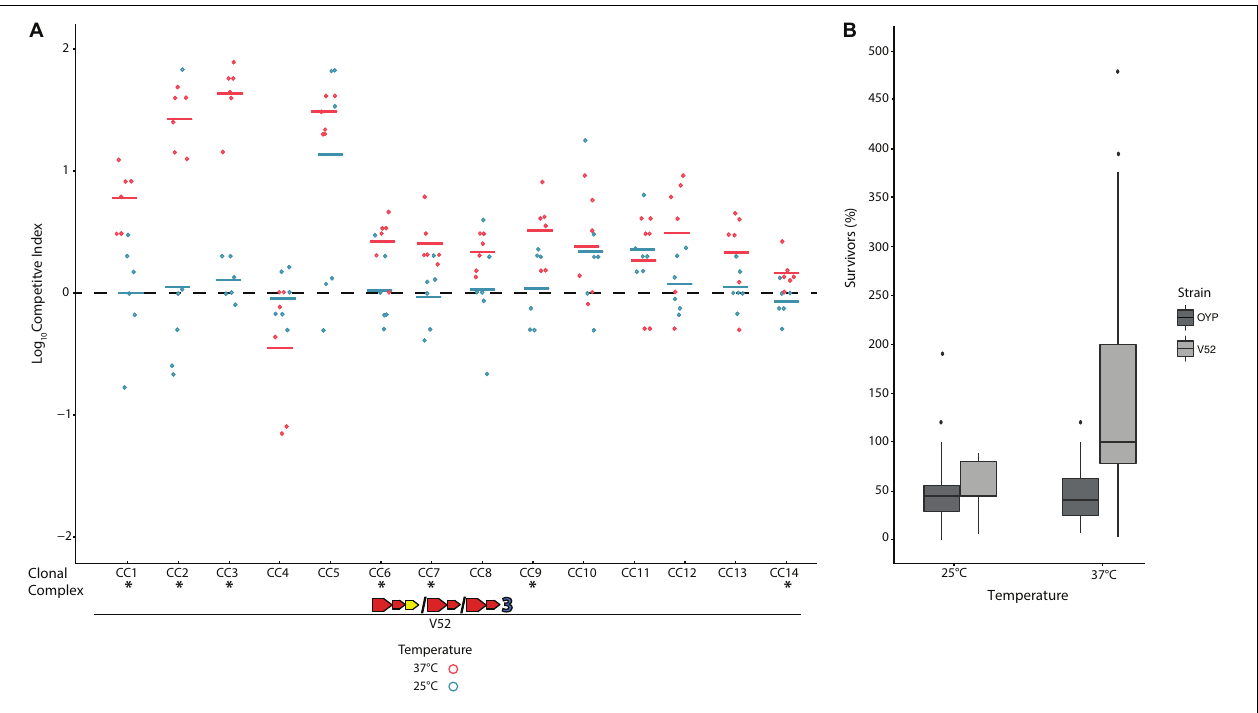
FIGURE 2 | Competition of a toxigenic Pandemic Generating lineage Vibrio cholerae strain against non-toxigenic natural isolates at environmental and human host temperatures. The clinical V. cholerae strain V52 (Zinnaka and Carpenter, 1972) was competed on agar plates against environmental V. cholerae isolates from Oyster Pond (MA, United States) in equal concentration at either 25 ◦ C or 37 ◦ C over 4 h. (A) Dots indicate the log competitive index (CI) for each replicate ( N = 6) at 37 ◦ C (red) and 25 ◦ C (blue), with the average shown as a bar on the y -axis. A positive log CI indicates a favorable outcome toward V52, and a negative CI denotes environmental strains as the winner. Asterisks (*) indicate statistically significant differences in mean CI values between 25 ◦ C and 37 ◦ C competitions from two-tailed, unpaired t tests ( p < 0.05). (B) Percentage of surviving cells compared to the original input for V52 and all environmental strains after 4 h of competition at 25 ◦ C and 37 ◦ C. Box-and-whiskers plots show median, 25th and 75th percentiles (upper and lower hinges), and 1.5 interquartile range (whiskers). Outliers are shown as individual